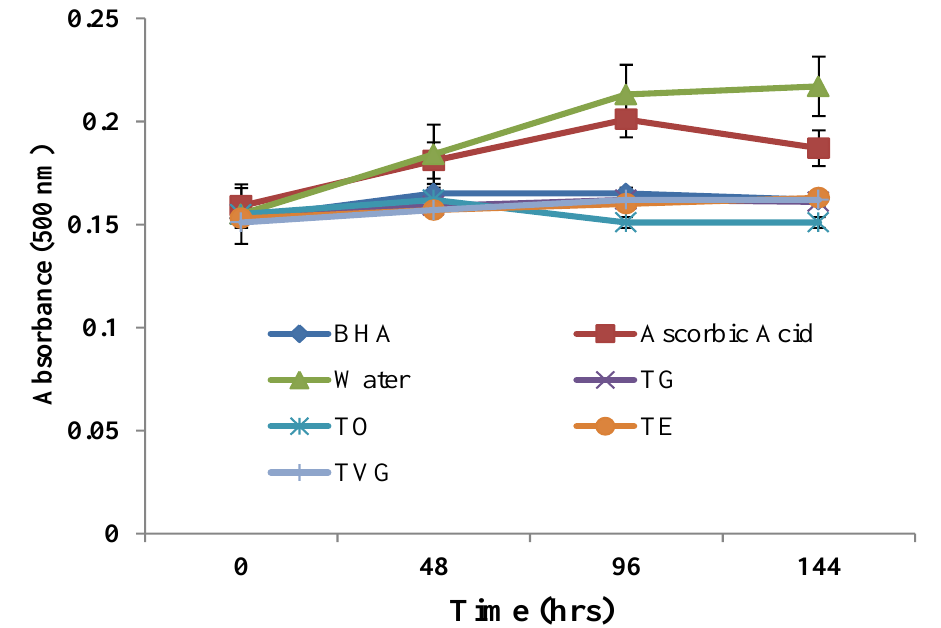
Figure 3. Linoleic acid peroxidation inhibitory activity of four different tannin isolates. TO: tannin oenologique; TVG: tannin VR grape; TG: tannin galalcool; TE: tannin VR supra elegance. Mean ± SD (N = 3). Means with different letters are significantly different ( p < 0.05).